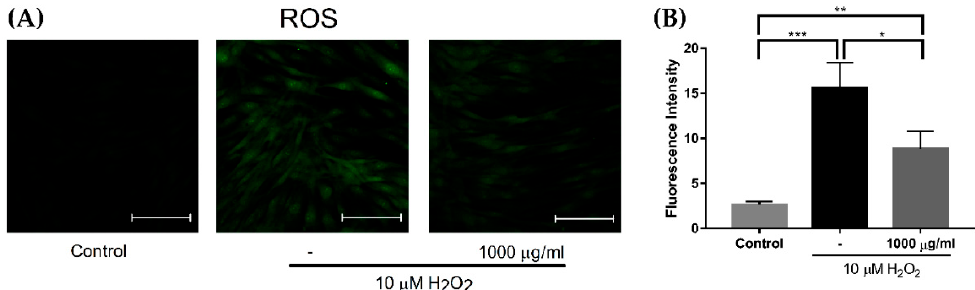
Figure 7. Visualization of ROS production in HDF cells ( A ). ROS production was stimulated by 10 μ M of H 2 O 2 treatment and significantly reduced by 1000 μ g/mL of EverCTP TM (NEWTREE Co., Ltd., Seoul, Korea) treatment ( B ); * p < 0.05, ** p < 0.01, *** p < 0.005, independent samples t -test. Scale bar indicates 100 μ m. ROS, reactive oxygen species; HDF, human dermal fibroblast; H 2 O 2 , hydrogen peroxide.